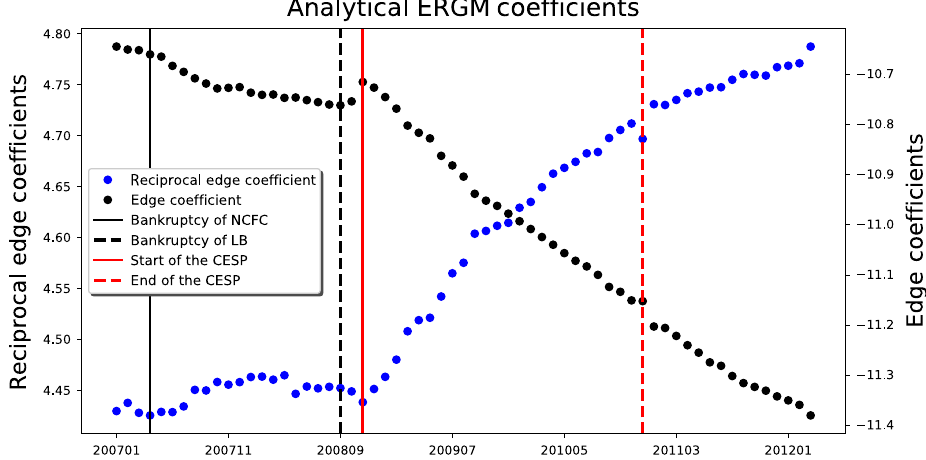
Fig. 4 Dynamic changes of coef fi cients in ERGM. Source data are provided as a Source Data